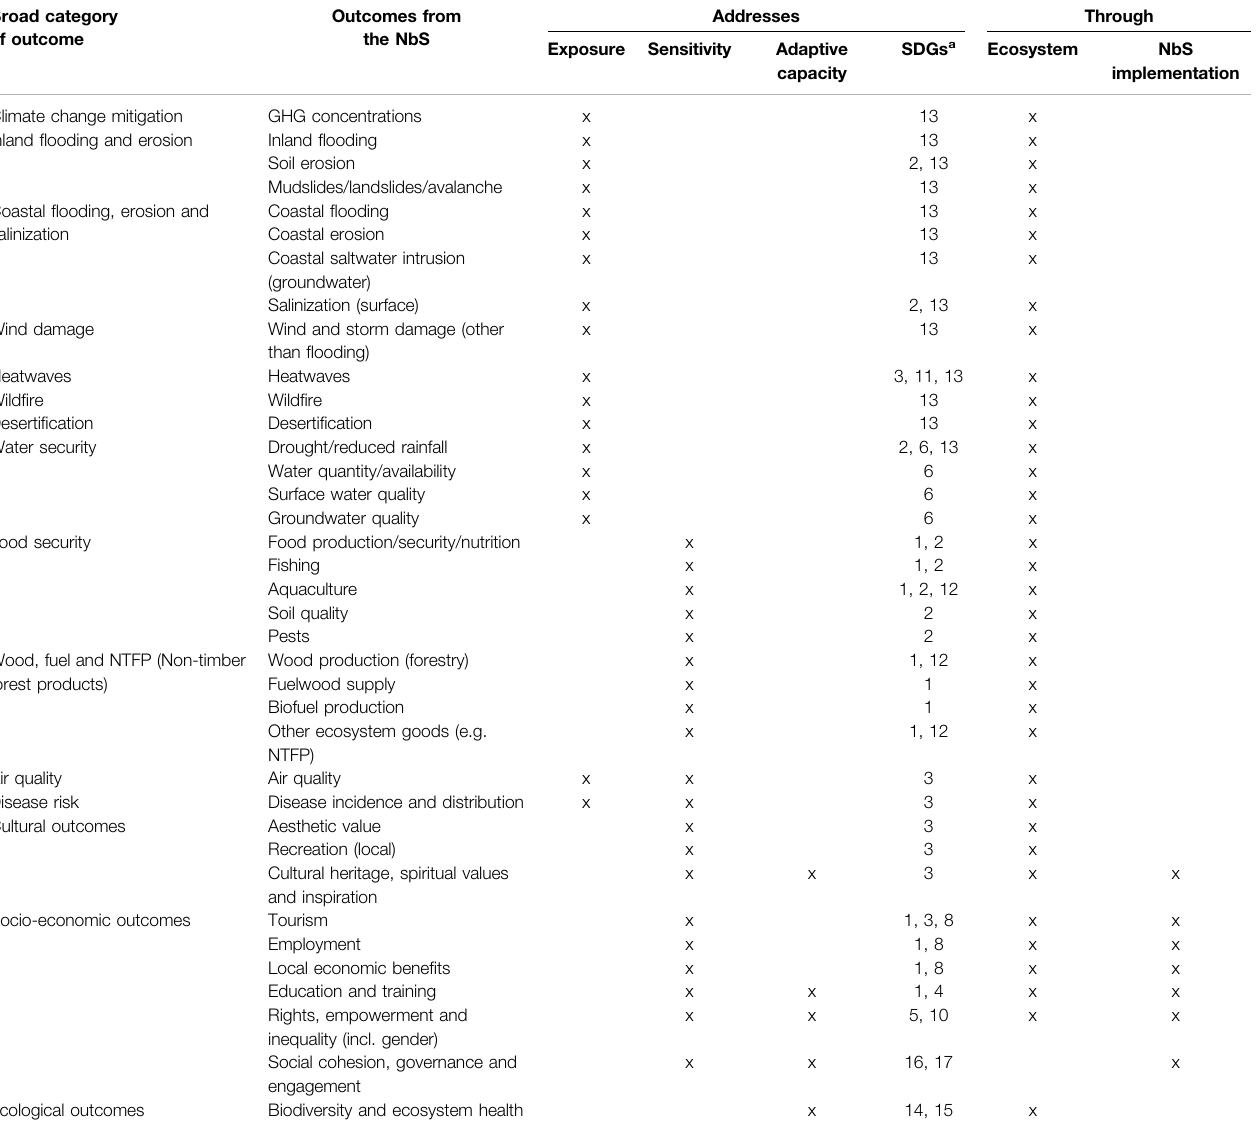
TABLE 1 | Target outcomes from NbS for addressing climate change and other SDGs, either through ecosystem change or through the NbS implementation process. Broad category of